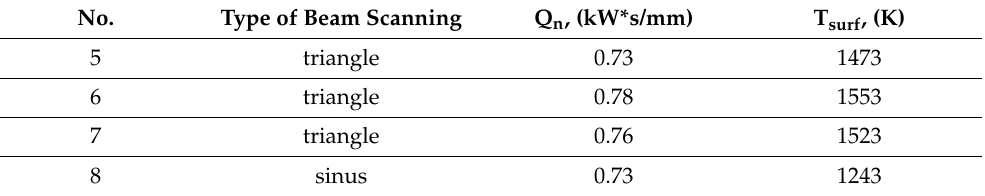
Table 3. Parameters of the mode of experiments on laser heat treatment with scanning of laser beam.